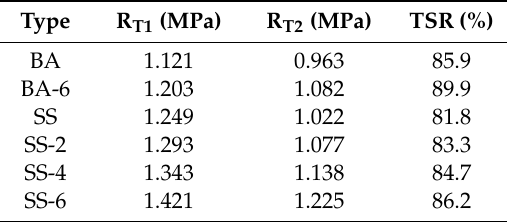
Table 4. Result of freeze–thaw splitting of di ff erent asphalt concretes.